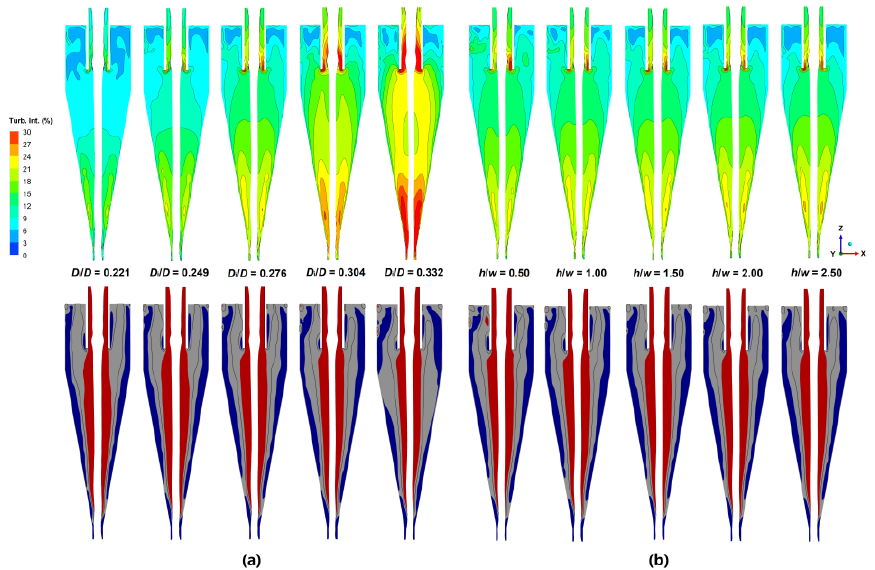
Figure 11. Effects of inlet structure on the distributions of turbulence intensity and AVWZ. ( a )—D i /D; ( b )—h/w.